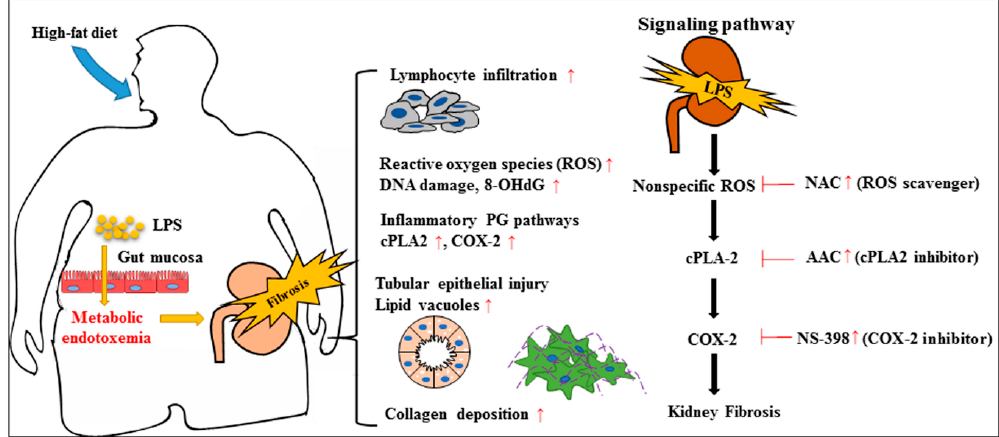
Figure 6. Potential mechanisms of obese kidney fibrosis induced by the fat–intestine–kidney axis.